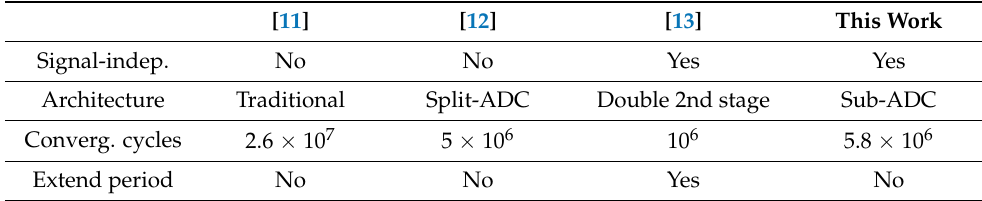
Table 2. Comparison with state-of-the-art calibrations.